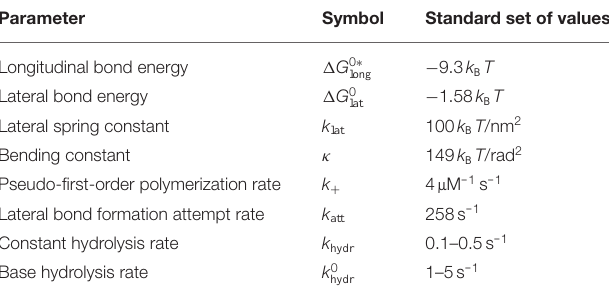
TABLE 2 | Free parameters of our MT model and the “standard set” of their values that we will focus on in the rest of the paper. Parameter Symbol Standard set of values Longitudinal bond energy